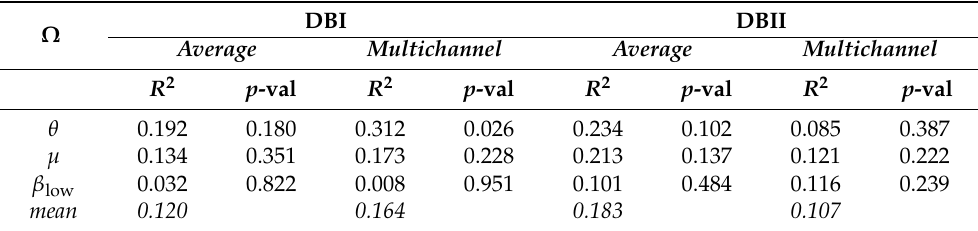
Table 2. Prediction performance of the multiple linear regression for the graph indexes extracted from the resting-state data.